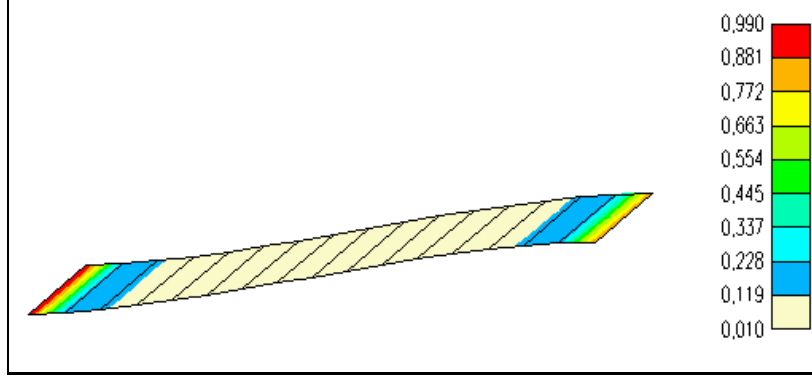
Figure 17. Damage contour plot in the deformed con fi guration of the PA66GF30 specimen. 6. Conclusions The present paper introduced a new 3D anisotropic fatigue damage model that is based on phenomenological principles. The model is used to predict the mechanical behavior of short glass fiber-reinforced polyamide 66 when subjected to fatigue tests. The model merges both the hyperelastic approach and continuum damage mechanics in the same framework. This model allows taking into account the orientation of the fibers by considering the differ- ent fiber contents. To determine the hyperelastic constitutive model, tensile tests were con- ducted in both the longitudinal and transverse directions. The fatigue damage model was incorporated into an in-house finite element code, and a parametric study was conducted to examine how the model’s evolution and kinetics were affected by the model parameters. This sensitivity analysis enabled us to enhance the procedure for determining the parame- ters of the fatigue damage model. The accuracy of the proposed model was tested against experimental results, which demonstrated its effectiveness. The simulated results accurately predicted the evolution of damage and captured the specific damage kinetics related to